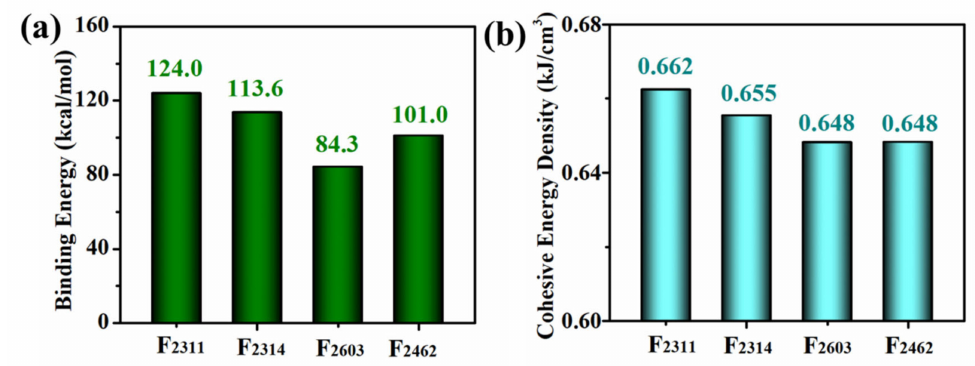
Figure 3. The binding energy ( a ) and cohesive energy density ( b ) of ε -CL-20 with four kinds of fluorine